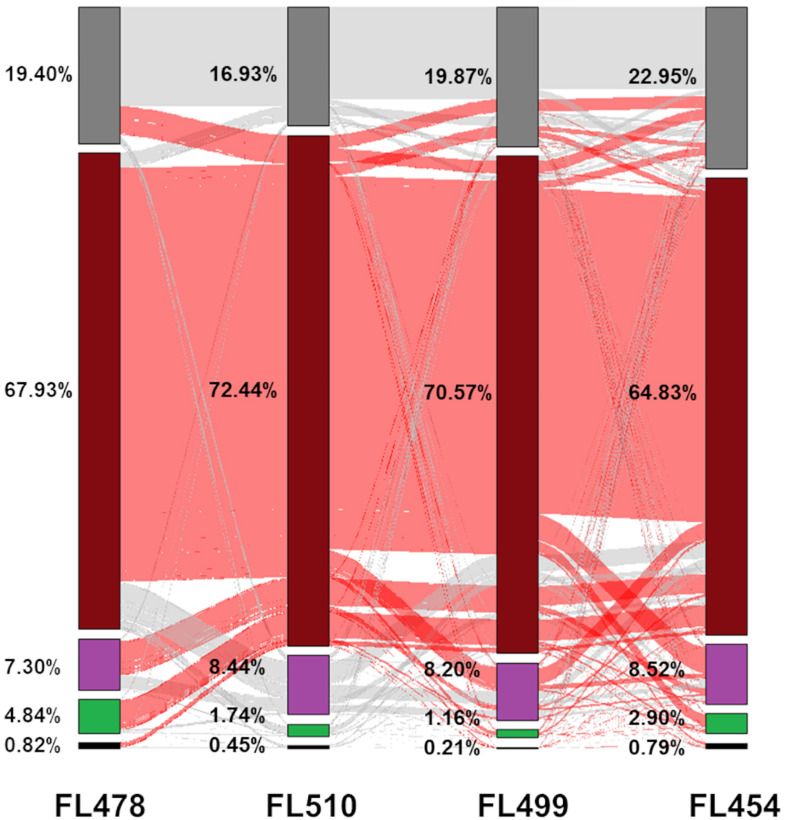
Analysis of the transmission of gene expression signatures from parents to offspring. Each protein-coding gene in the comparative transcriptome matrix was examined to trace the parental origin of respective expression patterns and classified into five categories: (1) complete inheritance (black), meaning that expression profiles were the same in both parents and in the RIL; (2) inherited from IR29 (green), meaning that the RIL had the same expression as IR29; (3) inherited from Pokkali (violet), meaning that the RIL had the same expression as Pokkali; (4) non-parental (brick red), meaning the expression pattern of the gene followed neither parent (deviant or transgressive); or (5) genes was excluded in the analysis due to very low transcript abundance (near zero) or extremely outlying values (gray). The proportion of genes shared with another category is denoted by the red and gray lines in between the bars.